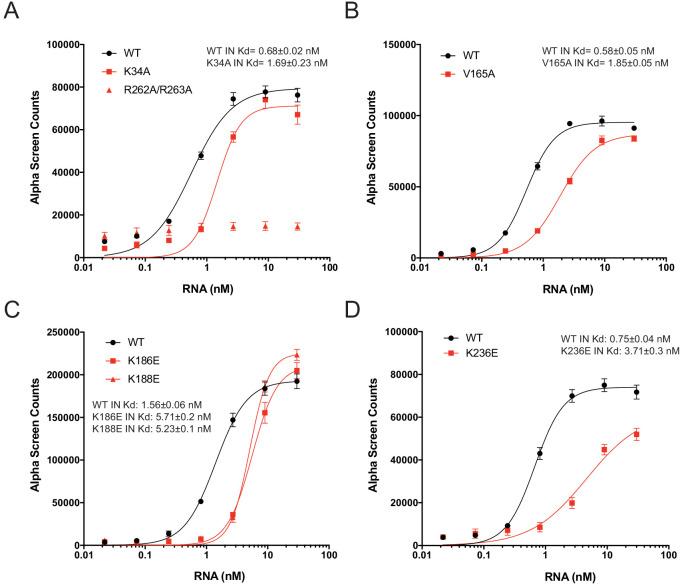
RNA-binding properties of Class II IN mutants in vitro.(A–D) Analysis of 100 nM WT or mutant INs binding to biotinylated TAR RNA by AlphaScreen assay. Graphed data is the average of three independent experiments and error bars indicate standard deviation.